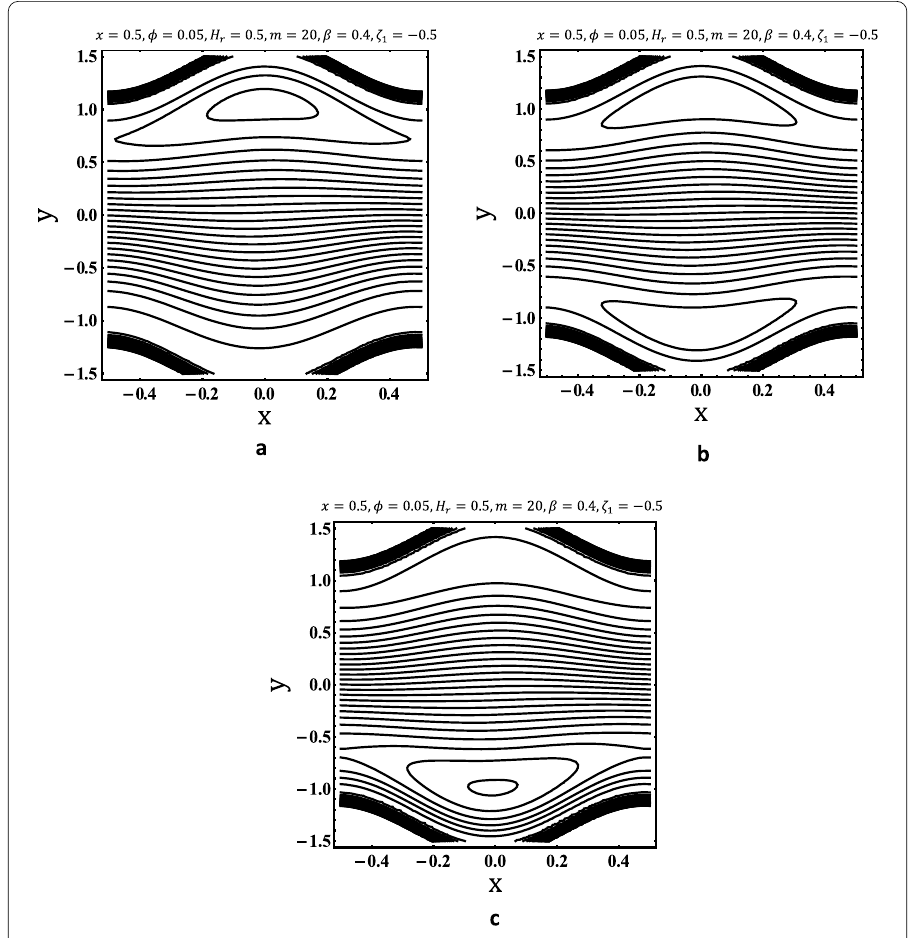
Figure 8 Streamline distribution for: ( a ) ζ 2 = –0.1, ( b ) ζ 2 = –0.5, and ( c ) ζ 2 = –1.0.